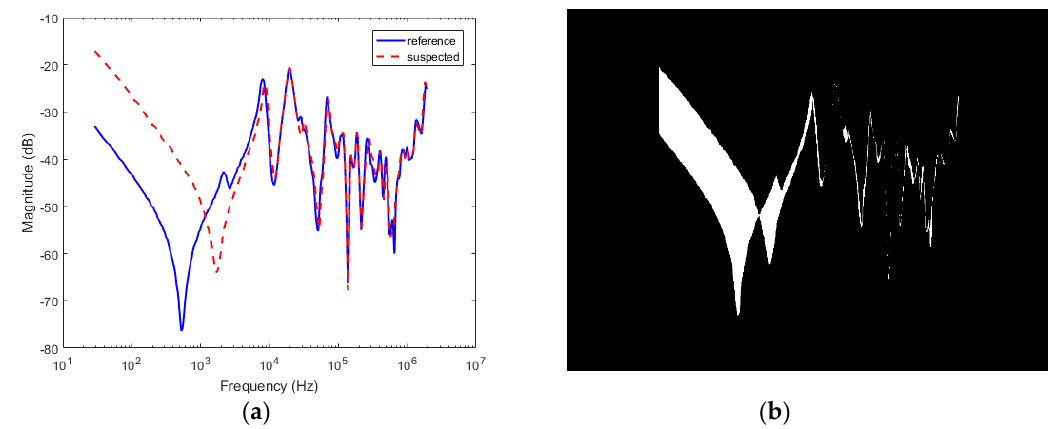
Figure 1. Examples of a representation of frequency response (FR) data: ( a ) Magnitude (dB) versus frequency spectrum with double logarithmic scales; and ( b ) frequency response analysis (FRA) image after binarization.